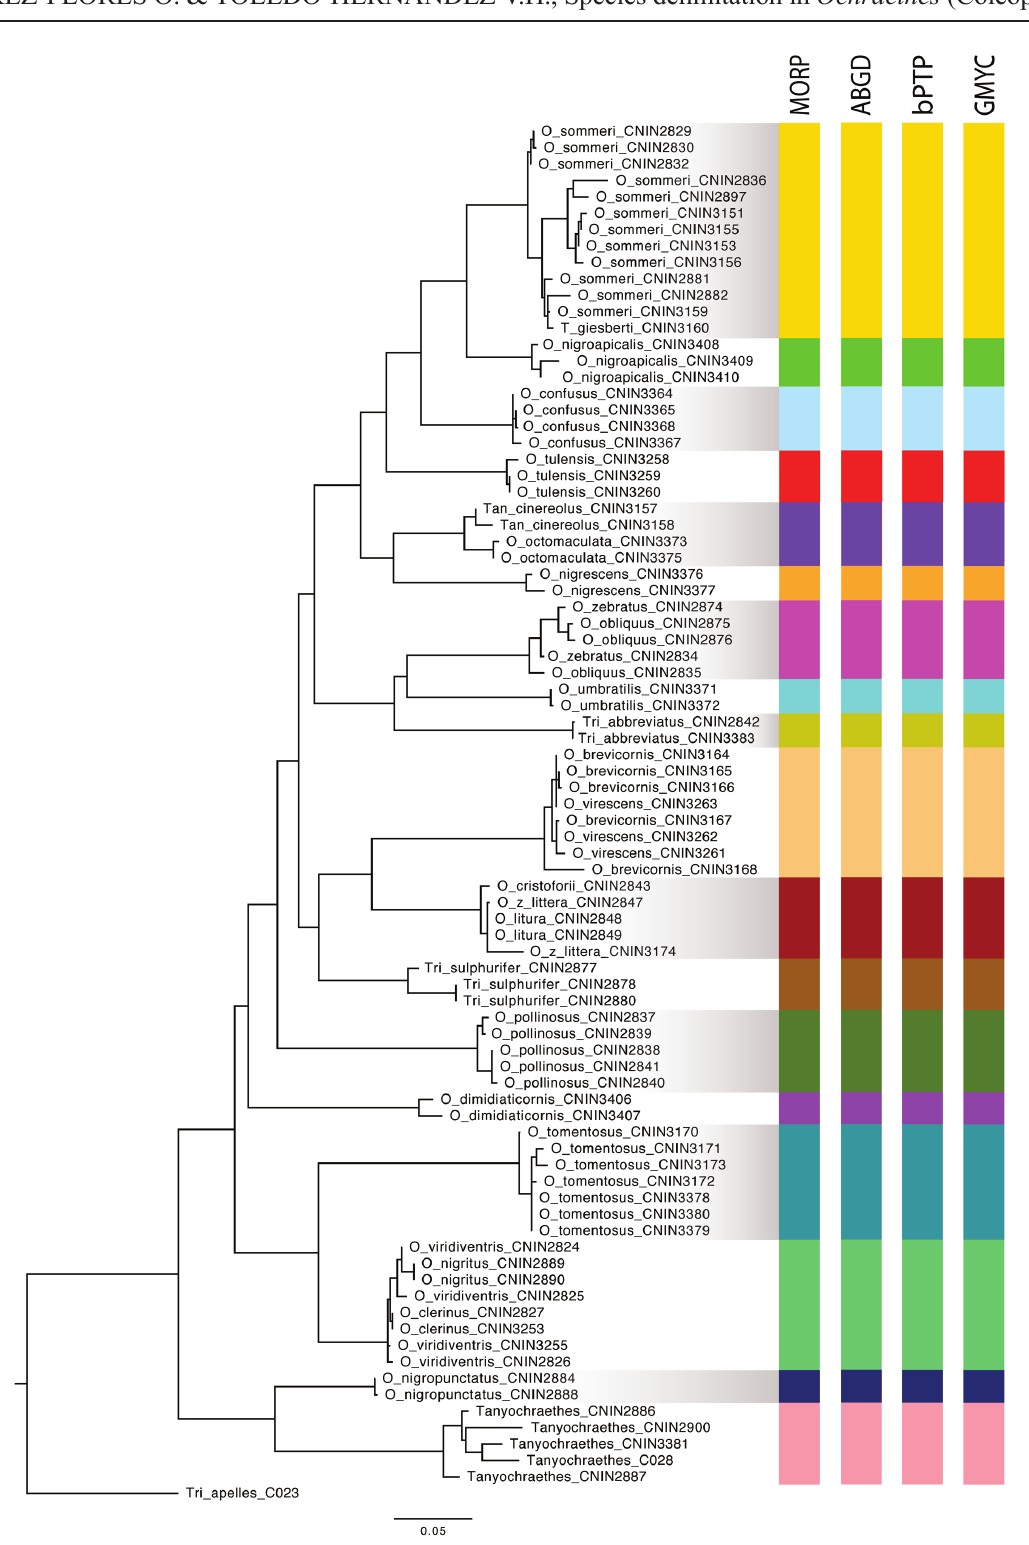
Fig. 5. Species delimitation in Ochraethes Chevrolat, 1860. Maximum likelihood tree inferred from COI in IQ TREE. The molecular operational taxonomic units (MOTU) are separated by colour bars. Abbreviations: ABGD = ast recursive analyses; bPTP = both Maximum likelihood and Bayesian analyses; GMYC = coalescence and yule analyses; MORP =